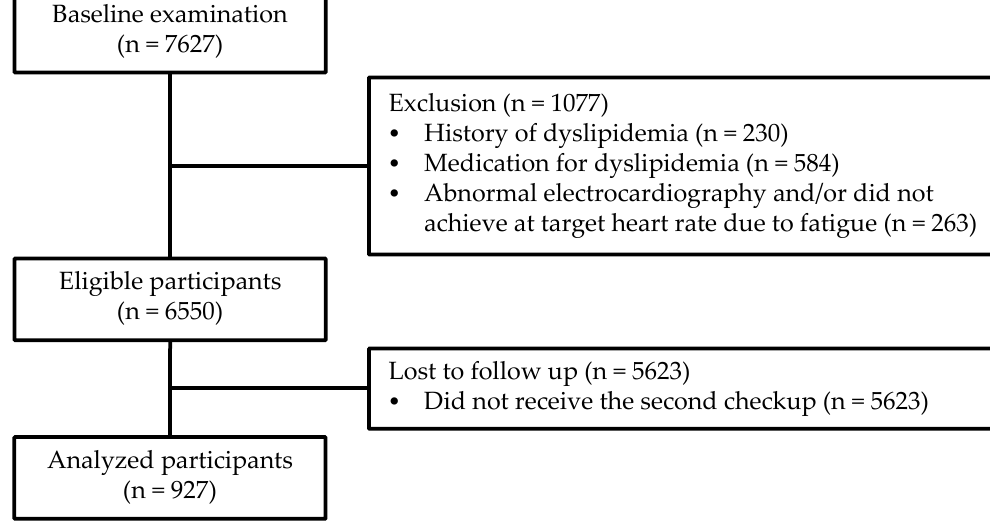
Figure 1. Flowchart of participant selection.